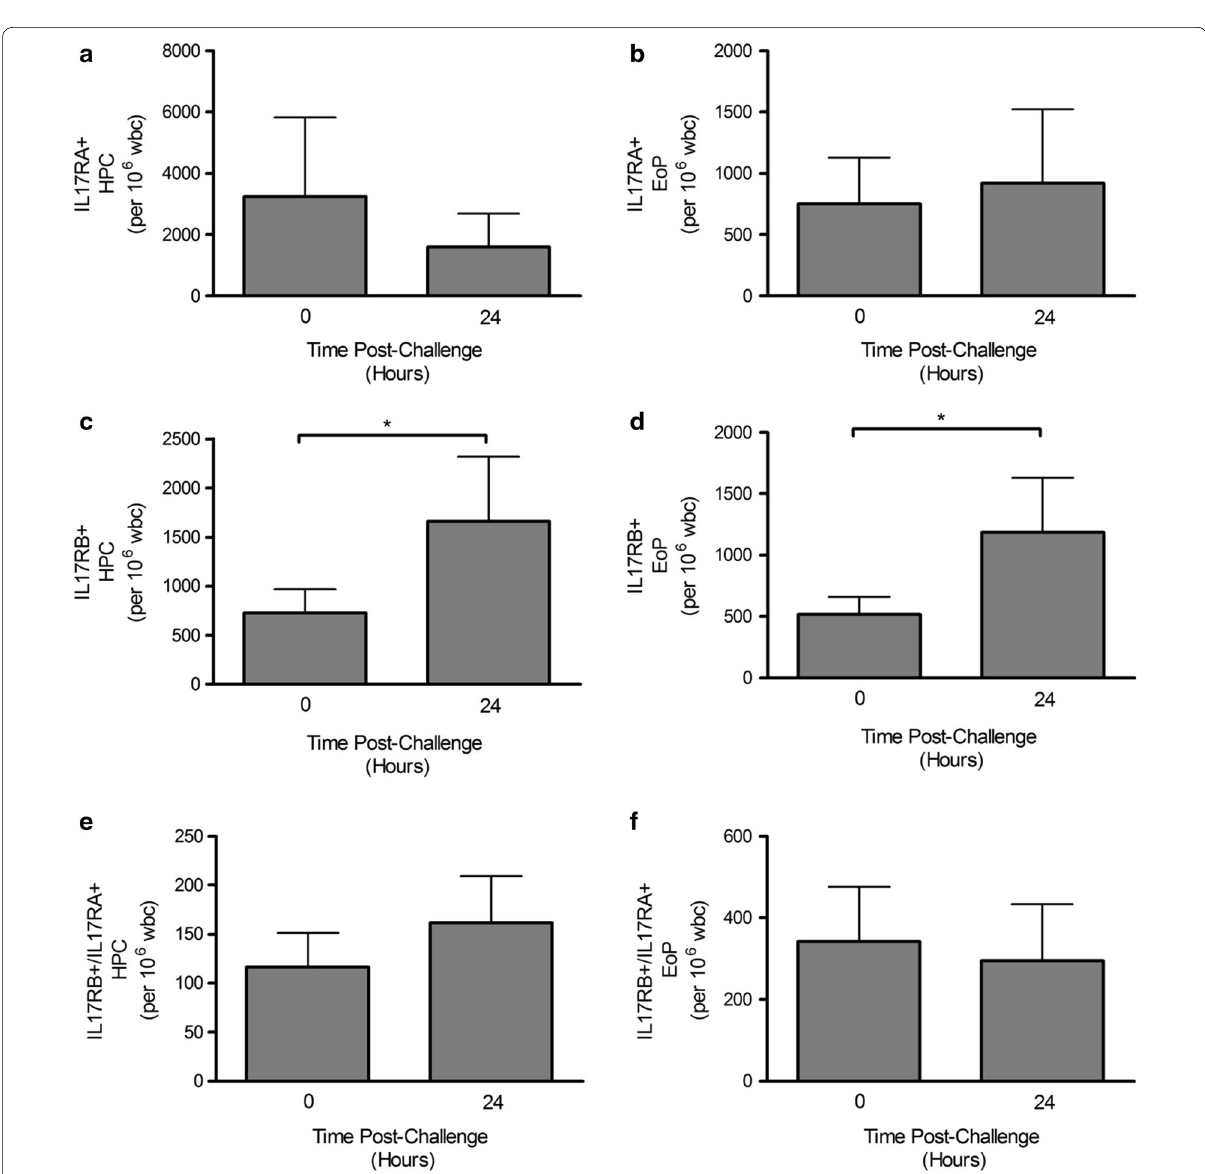
Fig. 1 Allergen-induced changes in IL-25 receptor expression on blood HPC and EoP. Expression of IL-17RA + ( a , b ), IL-17RB + ( c , d ) and IL-17RA/RB + ( e , f ) in mild allergic asthmatics following allergen-inhalation challenge. There was a significant increase in the number of HPC and EoP expressing IL-17RB + 24 h post-allergen inhalation challenge. Data are mean